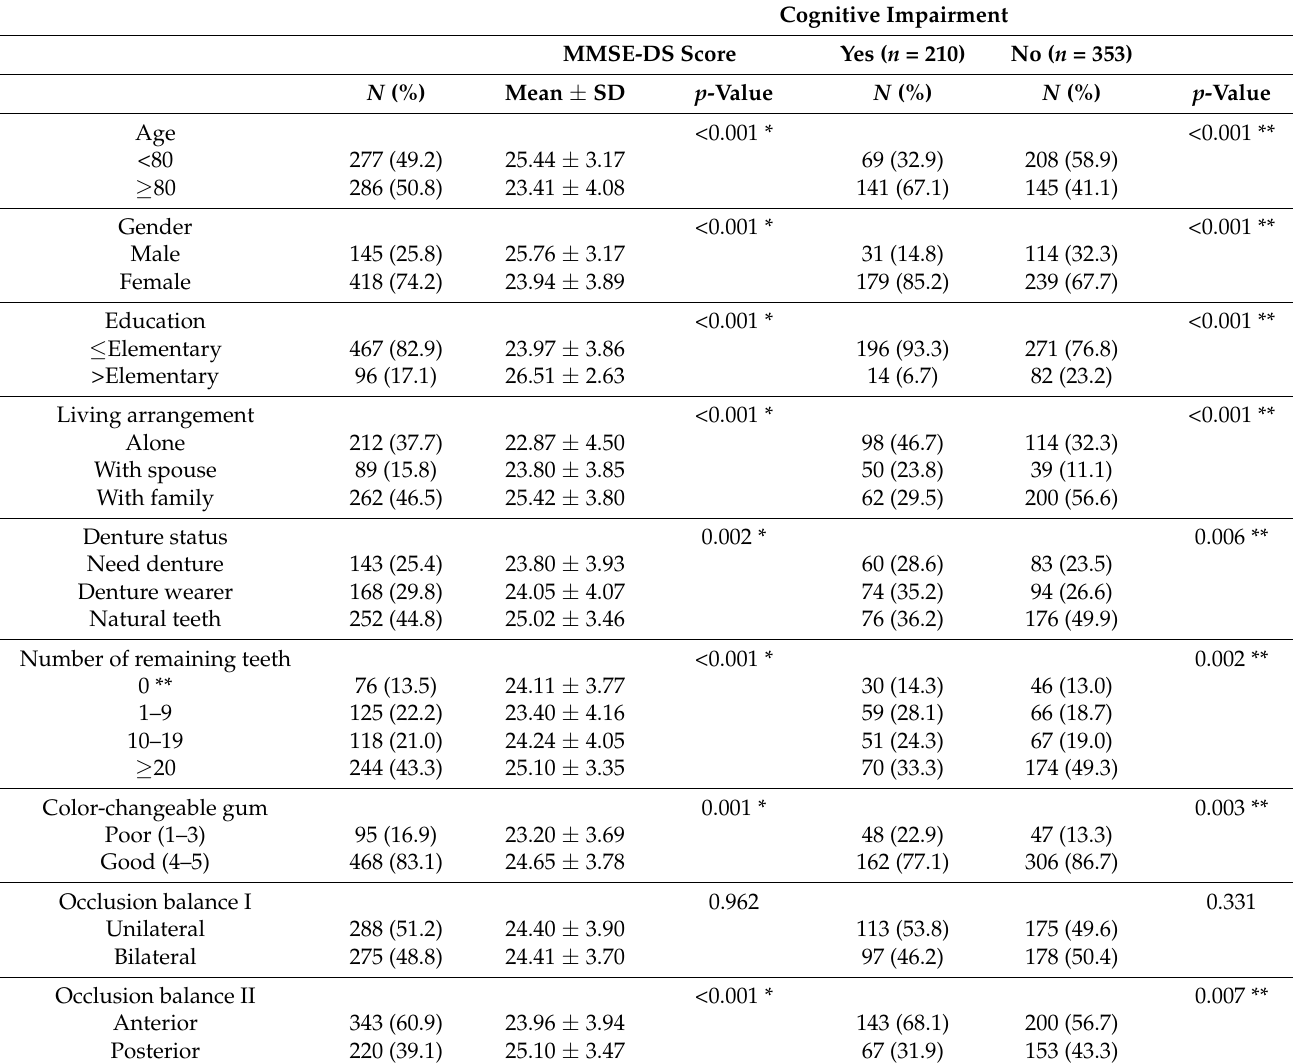
Table 1. Cognitive function with socio-demographic and chewing